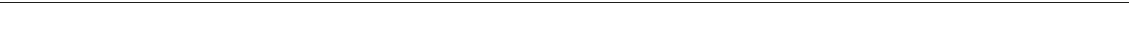
Fig. 5 Improved metabolic pro fi le after in vivo administration of autophagy enhancer with increased microsomal stability (MSL-7) to ob/ob mice. a Chemical structure of chemically modi fi ed autophagy enhancer, MSL-7, with increased microsomal stability [2-(2-chlorophenyl)-5-methoxy-4- (phenylsulfonyl)oxazole]. b HeLa cells transfected with tandem mRFP-GFP-LC3 construct were treated with MSL-7 for 1 h, and were subjected to confocal microscopy (left panel). The numbers of yellow and red punctae representing autophagosomes and autophagolysosomes, respectively, were counted (right) ( t = 3.5, df = 4 for autophagosome; t = 5.8, df = 4 for autophagolysosome). c TFEB-GFP -transfectant HeLa cells were treated with MSL-7 for 4 h, and were subjected to confocal microscopy (left panel). The number of cells with nuclear TFEB was counted (right) ( t = 5.0, df = 2). d , e Eight-week-old male ob/ob mice or 8-week-old male C57BL/6 mice were treated with 50 mg/kg MSL-7 3 times a week for 8 weeks, and nonfasting blood glucose level ( d ) and body weight ( e ) were monitored ( F = 40.9, df = 1 for d ). f IPGTT was conducted after in vivo administration of MSL-7 for 8 weeks ( F = 62.3, df = 1). g AUC of the IPGTT curve in f ( F = 25.3, df treatment = 3, df residual = 27). h ITT was conducted after in vivo administration of MSL-7 for 8 weeks ( F = 50.1, df = 1). i AUC of the ITT curve in h ( F = 57.7, df treatment = 3, df residual = 26). All data in this fi gure are the means ± s.e.m. from ≥ 3 independent experiments performed in triplicate (scale bar, 20 μ m). * P < 0.05, ** P < 0.01 and *** P < 0.001 by one-way ANOVA with Tukey ’ s post-hoc test ( g , i ), two-way ANOVA with Bonferroni ’ s post-hoc test ( d , f , h ) or two-tailed Student ’ s t -test ( b , c